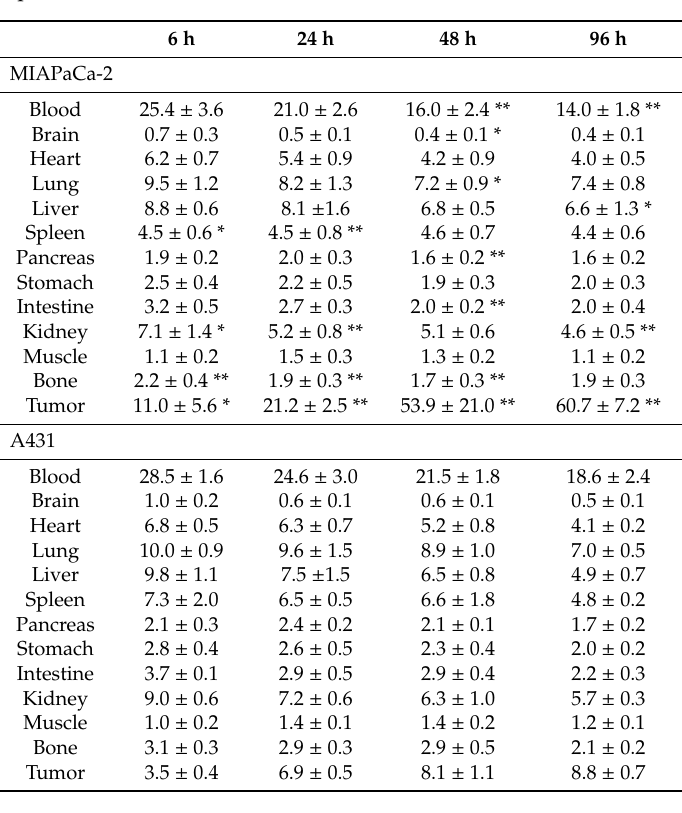
Table 1. Biodistribution of 111 In-labeled anti-CD73 antibody 063-213 in tumor-bearing mice. Data are represented as the mean of %ID / g ± standard deviation ( n = 5). * p < 0.05, ** p < 0.01 vs. A431-bearing mice at each time